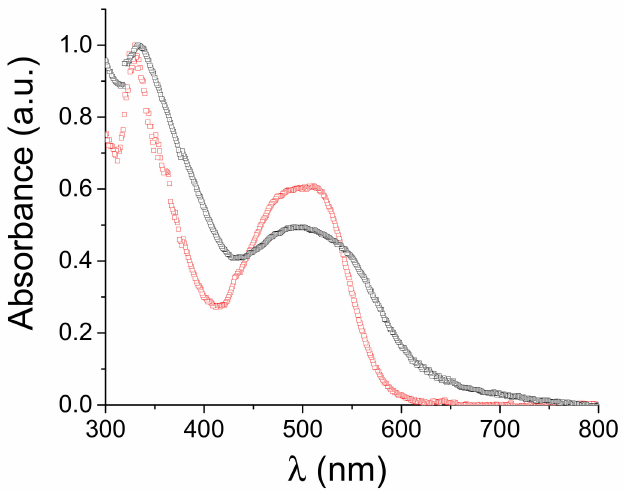
Figure 3. Normalized UV-Vis absorption spectra of BDT-C 60 in chloroform solution (red) and as thin film on glass